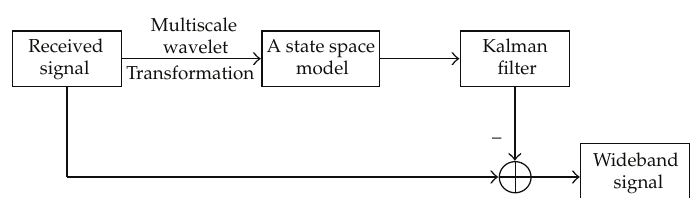
Figure 1: Estimated scheme of fractional noise suppression in UWB